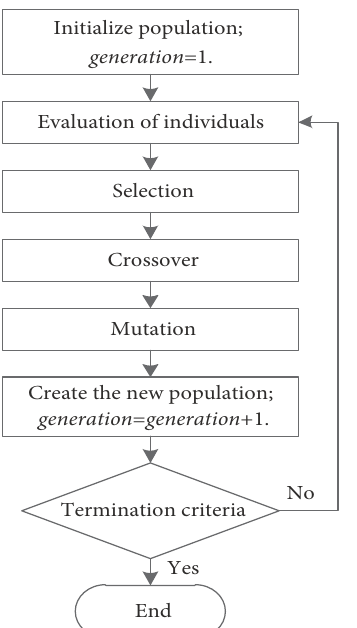
Figure 5: Flowchart of